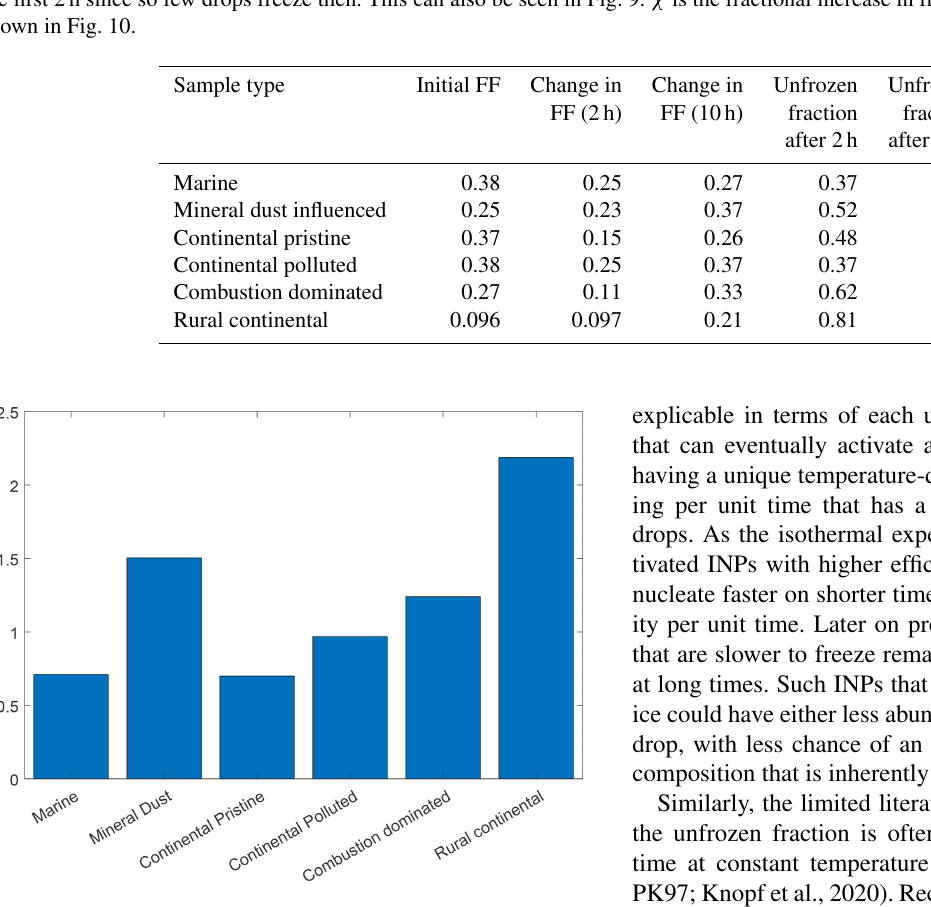
Figure 10. Fractional increase, χ , after 10h of the isothermal ex- periment in frozen fraction averaged as in Fig. 9 (initial and final yellow points), for the marine, mineral-dust-influenced, continen- tal pristine, continental polluted, combustion-dominated and rural continental samples of aerosol material (left to